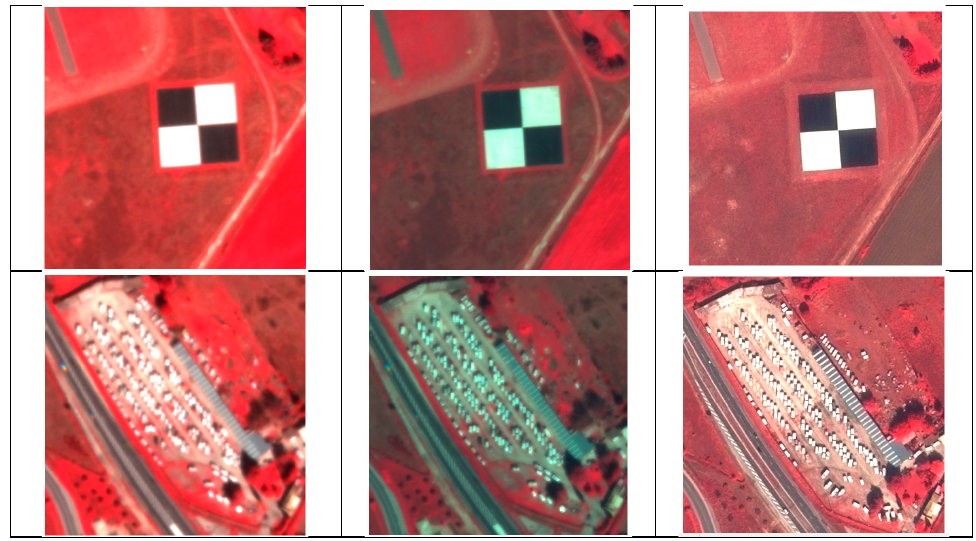
Figure 11. Examples of parts of images from the SkySat green band ( left ), the pan-sharpened green band ( middle ), and Pleiades ( right ) used for visual inspection.